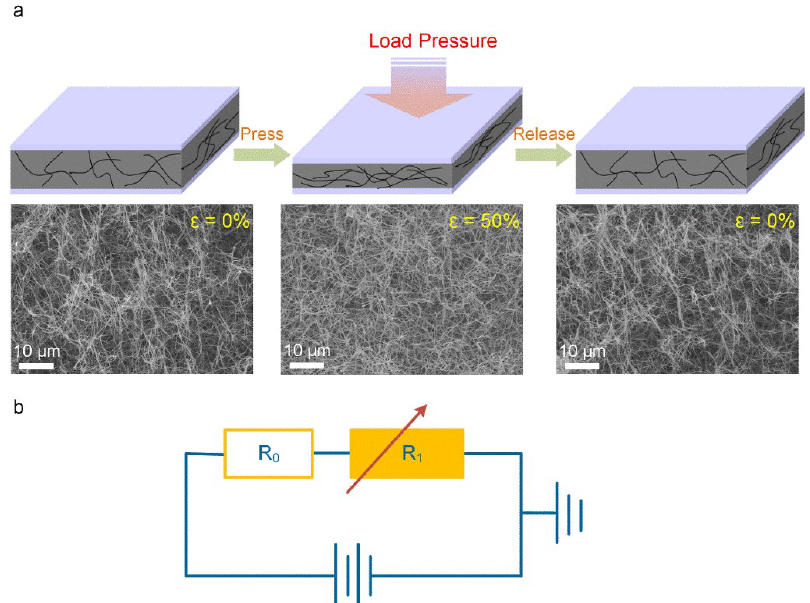
Figure 4. ( a ) Pressure sensing models of the synthesized CNTs sponge-based sensor under the press-release condition depicts the variation in the contact area of the CNTs network taking place with the compression deformation. The in situ SEM photographs of the CNTs sponge press-release dynamic process: The CNTs sponge in the original state (left), pressed state of ~50% (center), after releasing completely (right). ( b ) An equivalent circuit representation of the piezoresistive sensor based on CNTs sponge, where R 1 is ascertained by the internal voids distance of the CNTs sponge whereas R 0 has a constant value.